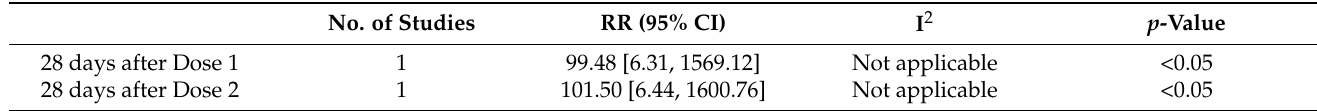
Table 10. RBD-binding enzyme immunosorbent assay antibody in the adenovirus vaccine